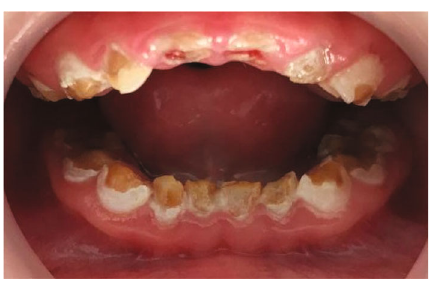
Figure 2: Intraoral view (preoperative